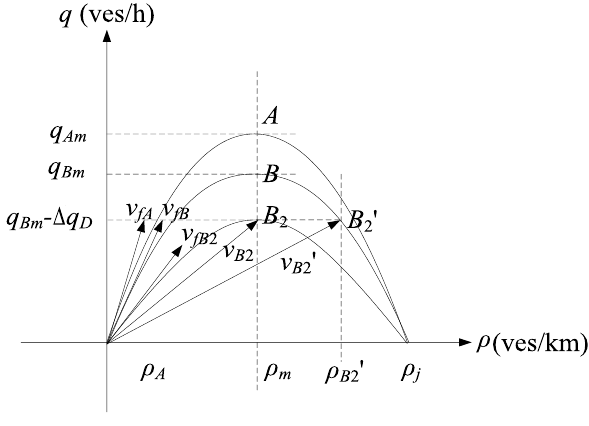
Fig. 7 The relationship between traffic flow rate and density of the unclosed restricted